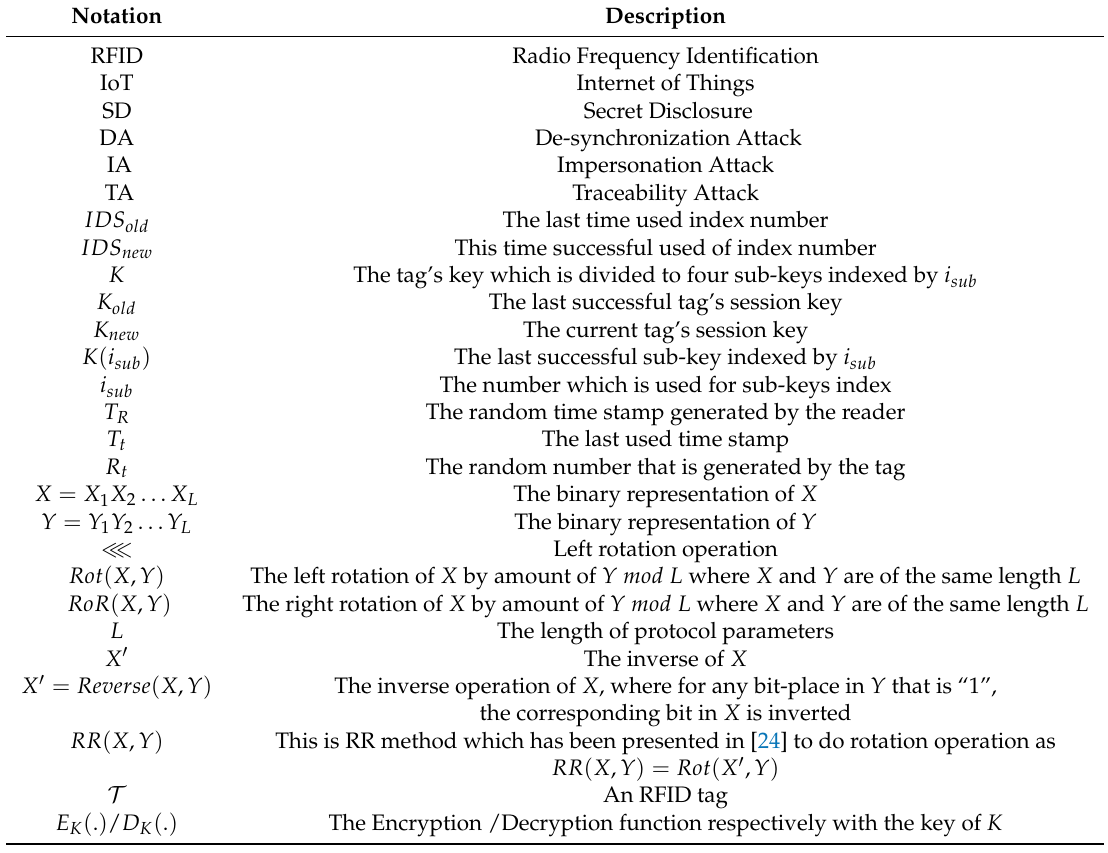
Table 1. Notations used in this